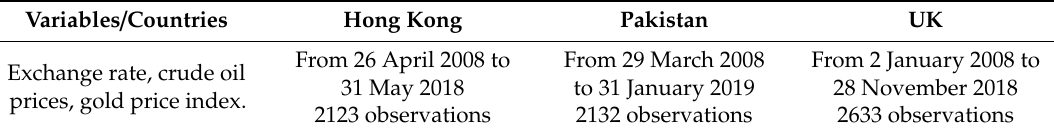
Table 1. Data description.